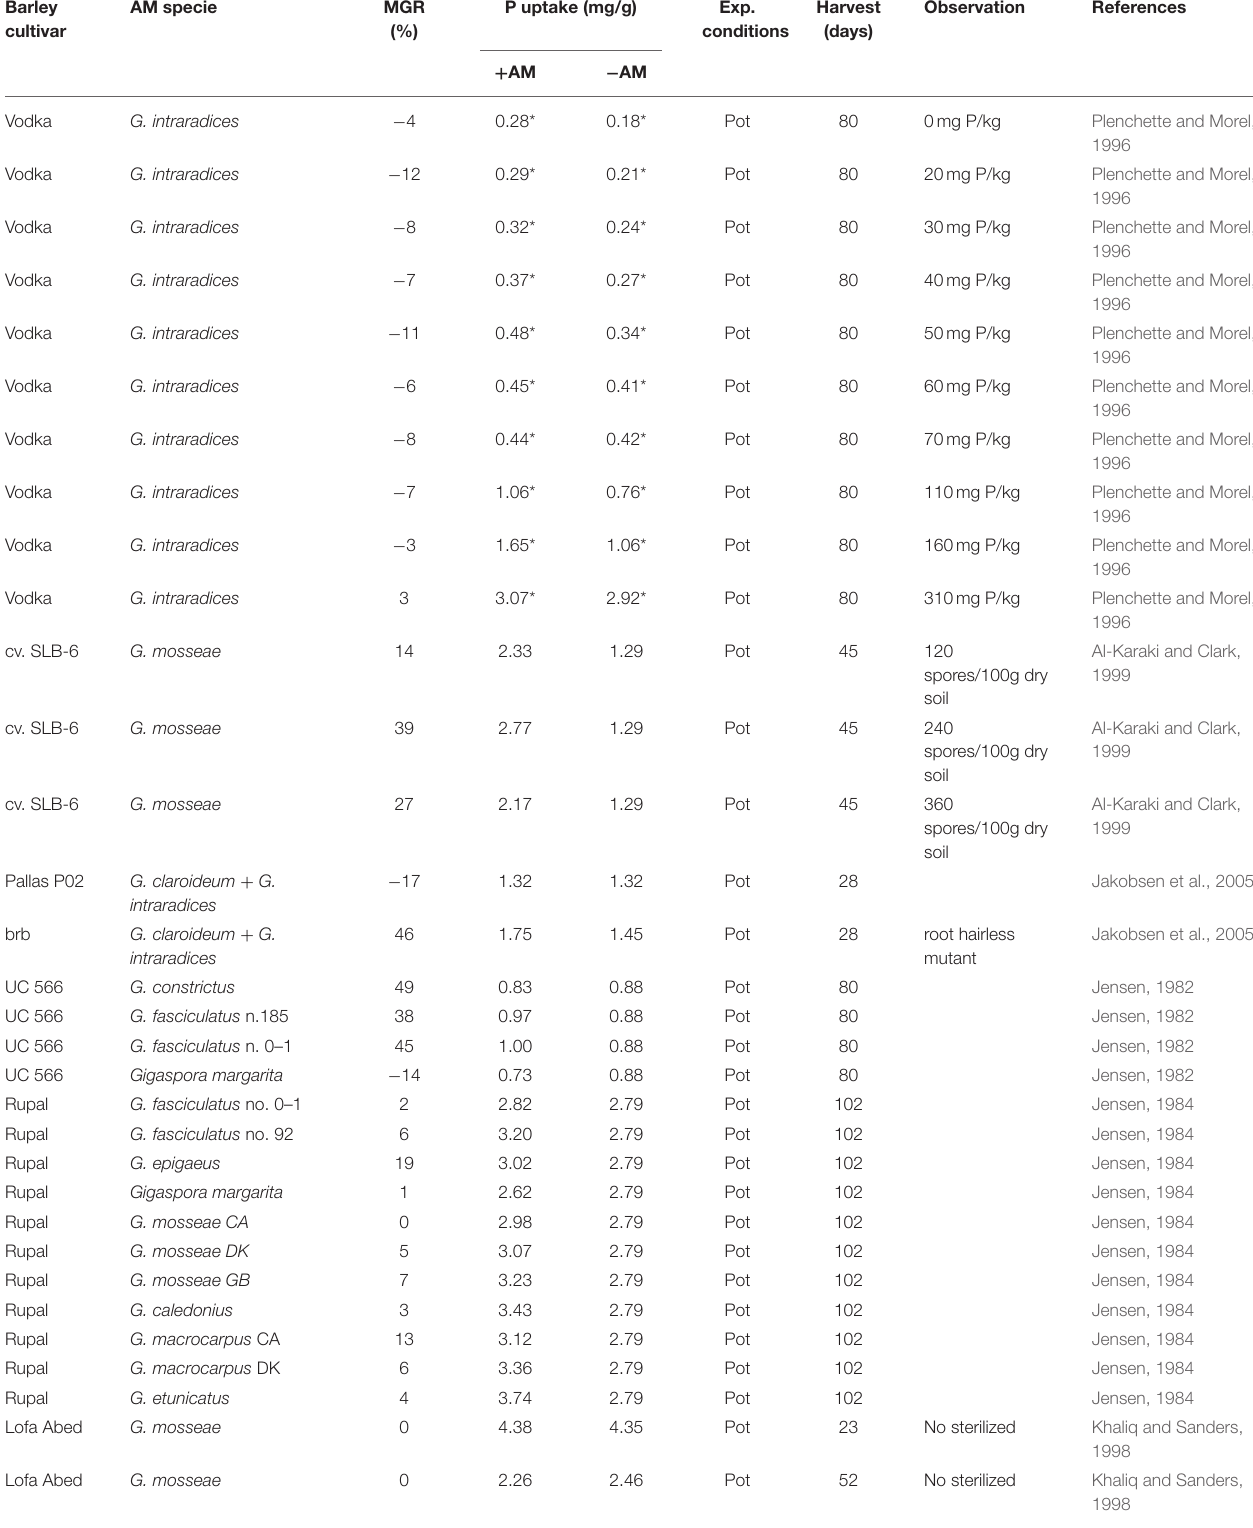
Table 1B | Mycorrhizal growth responses (MGR) and P uptake on mycorrhizal ( + AM) and non-colonized (–AM) barley ( H. vulgare L.) cultivars under greenhouse or field conditions and at different days after sowing (DAS). Barley